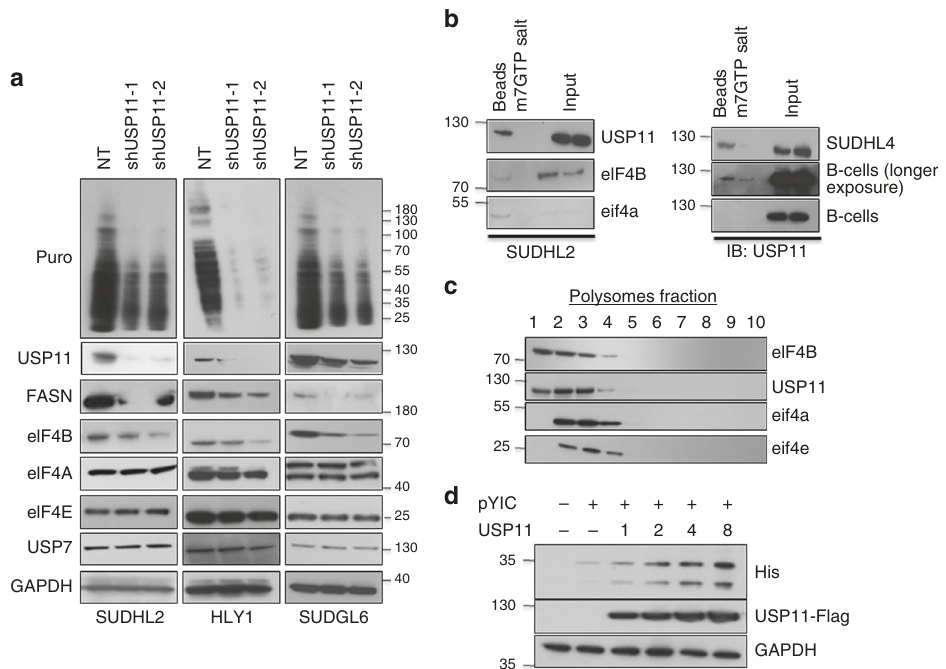
Fig. 5 USP11 directly regulates translation. a Indicated USP11 depleted stable cells were cultured in presence of puromycin (3 µ g/mL) for 30 min and lysates were probed for de fi ned antibodies. GAPDH was used as loading control. b Indicated cell lysates were incubated with m 7 GTP sepharose beads in the presence or absence of m 7 GTP salt. Co-eluted proteins were resolved and probed for indicated antibodies. c HLY-1 extracts were subjected to sucrose gradient density centrifugation. The gradient was fractioned; fractions were analyzed for indicated antibodies. d 293T cells were transfected with pYIC and indicated the amount of USP11 and or GFP. Post-transfection, cell lysates were resolved and probed with indicated antibodies. GAPDH was used as